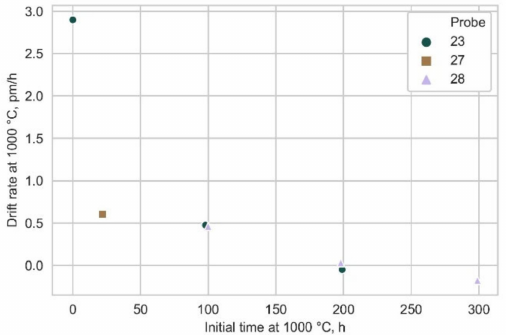
Figure 27. Drift rate at 1000 ◦ C for 3 Type-c FBGs packaged in quartz tubing, calculated by comparing the wavelength at 600 ◦ C before and after annealing at 1000 ◦